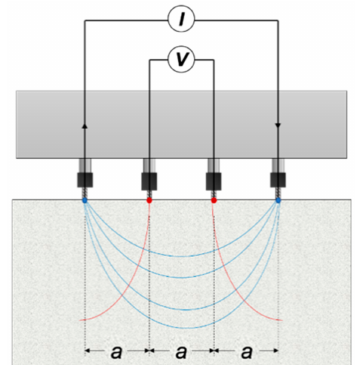
Figure 1. Wenner probe configuration, with “a” as the distance between the